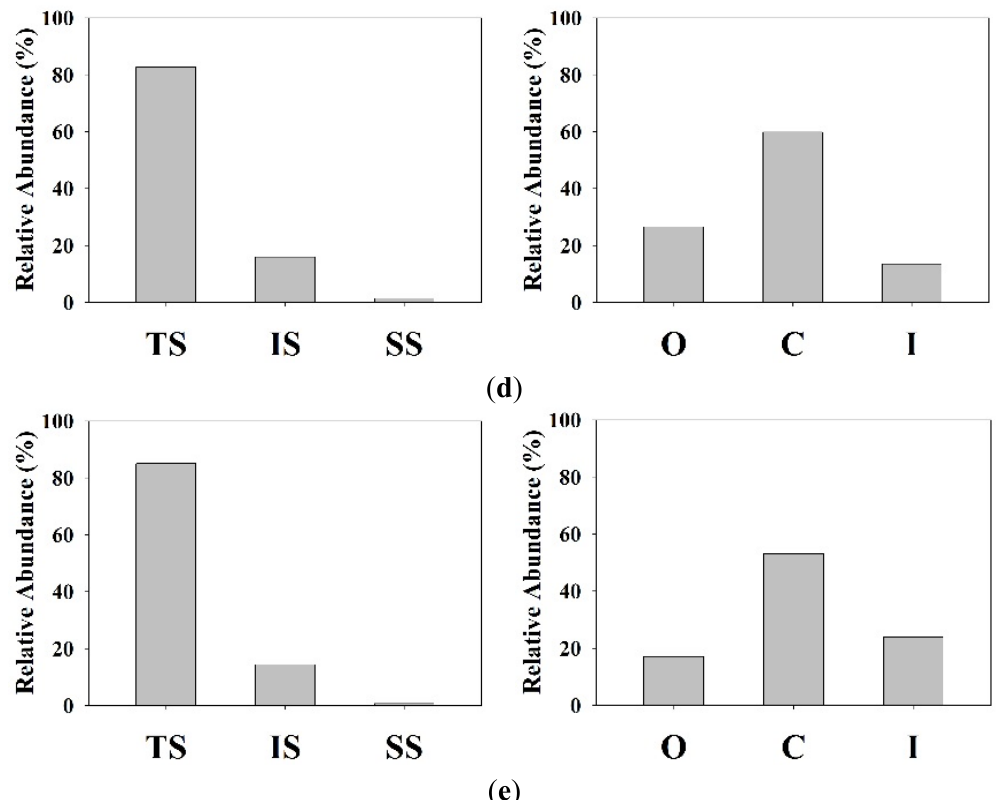
Figure 6. Comparison of tolerance and trophic species analysis in Nakdong River (TS: tolerant species, IS: intermediate species, SS: sensitive species, O: omnivores, C: carnivores, I: insectivores): ( a ) Reference: Zacco-Coreoleuciscus Community; ( b ) Group I: Zacco-Opsarichthys Community; ( c ) Group II: Zacco-Opsarichthys Community; ( d ) Group III: Opsarichthys - Zacco Community; and ( e ) Group IV: Opsarichthys-Micropterus